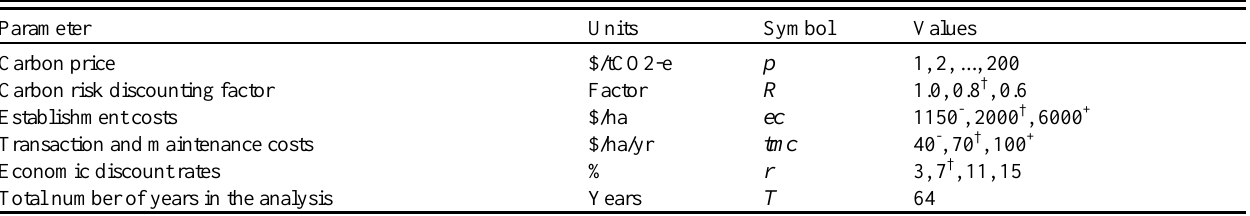
Table 1 . Summary of model parameters assessed in this study (- used in low cost scenario, † used in median scenario, + used in high cost